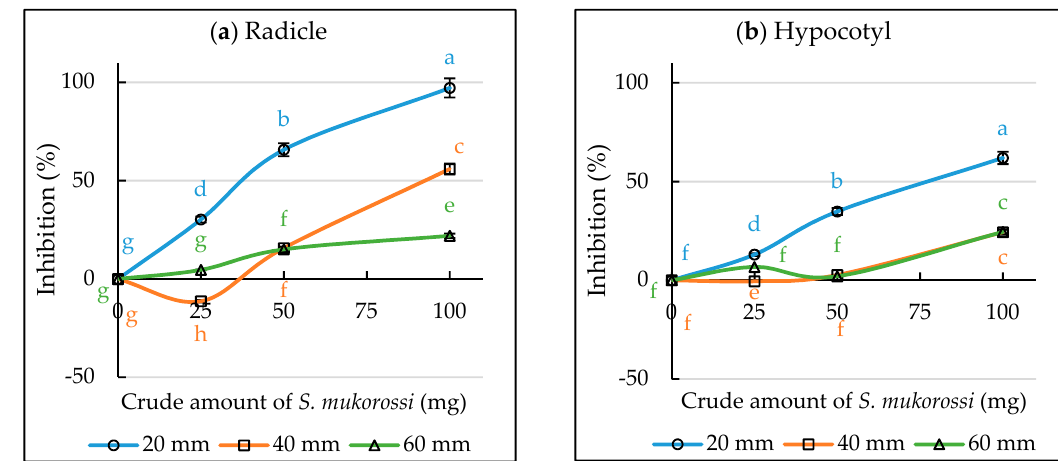
Figure 9. Single petri dish method evaluation. ( a ) Radicle inhibition ( b ) Hypocotyl inhibition. Distance consideration (20 mm, 40 mm, 60 mm), amount variation of S. mukorossi dry samples (100 mg, 50 mg, 25 mg), and correlation investigated control level of the growth variable of the ( a ) radicle and ( b ) hypocotyl of L. sativa seedlings. The data compared by Tukey’s HSD test and values are the average of three replications of ( ± ) standard error.